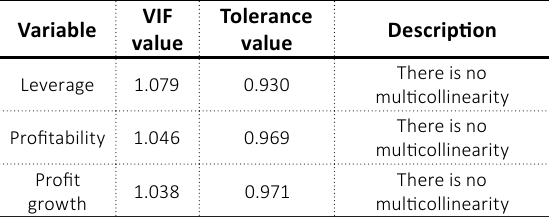
Table 2. Data normality test results